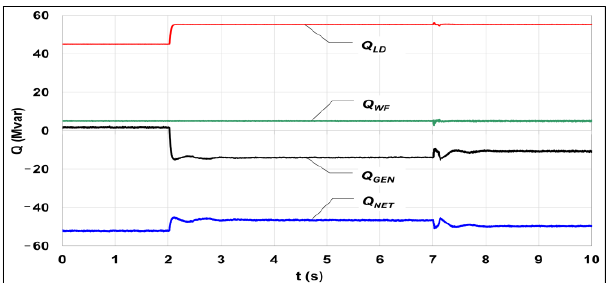
Figure 7. Changes in the active power balance in the system, resulting from the operation of the farm in the frequency regulation mode: P LD — active equivalent load power, P W F — active WF power, P GEN — active generator power, ΔP — active power losses in the network.